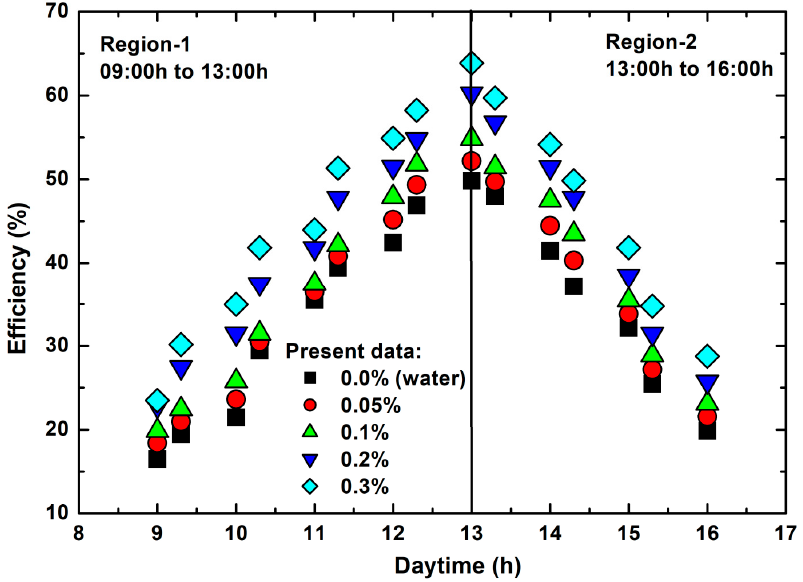
Figure 9. Solar radiation with respect to daytime.